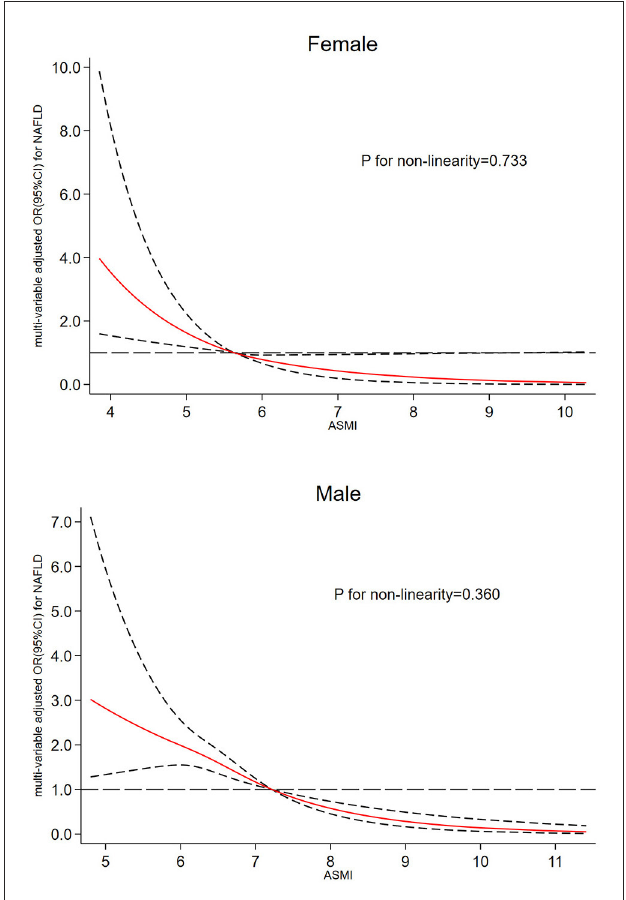
FIGURE2 Dose-response relationship between ASMI and risk of NAFLD in female and male. The restricted cubic spline regression analysis was adjusted for age, smoking, diabetes, hypertension, WC, BMI, TG, LDL-c, ALT, and AST. The long dashed line represents OR is equal to 1, red line and the area between the short dashed lines means ORs and their 95%